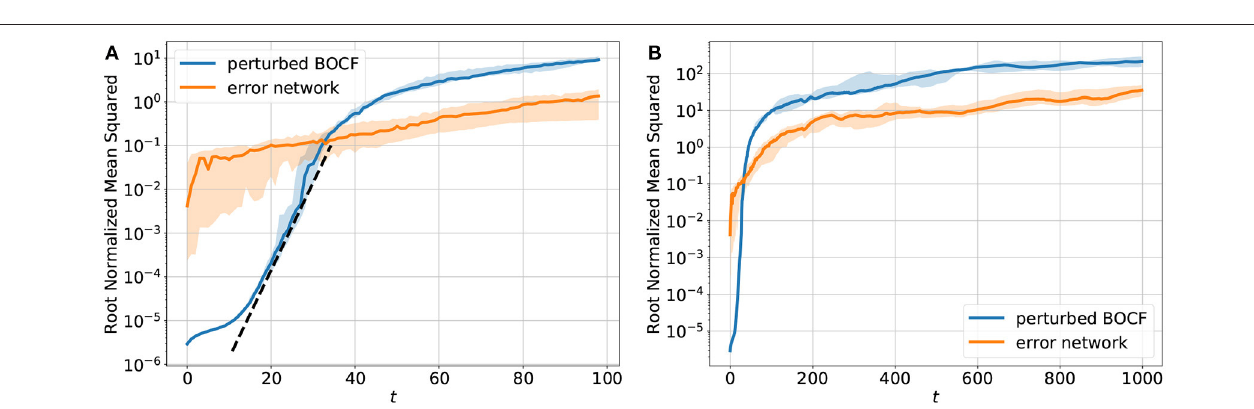
FIGURE 3 | Temporal development of (A) the Jensen-Shannon divergence (JSD) and (B) the root normalized mean squared error (RNMSE) for all variables u , v , w , s showing the deviation of the iterative network prediction (in a feedback mode) from the reference orbit obtained with the BOCF model. During the period [0 − 1000] the predicted and the true fields agree very well as indicated by very small values of the JSD. In the time interval (1000 − 3000] the JSD values increase until they saturate and the forecasts become very poor and useless. The RNMSE values show a similar increase in time but turn out to be more sensitive to minor deviations during the initial phase [0 − 1000] of the forecast. The solid curves show median values of JSD and RNMSE obtained from ten different initial values of u , v , w , s . The transparent areas visualize the 0.25 / 0.75 percentile.